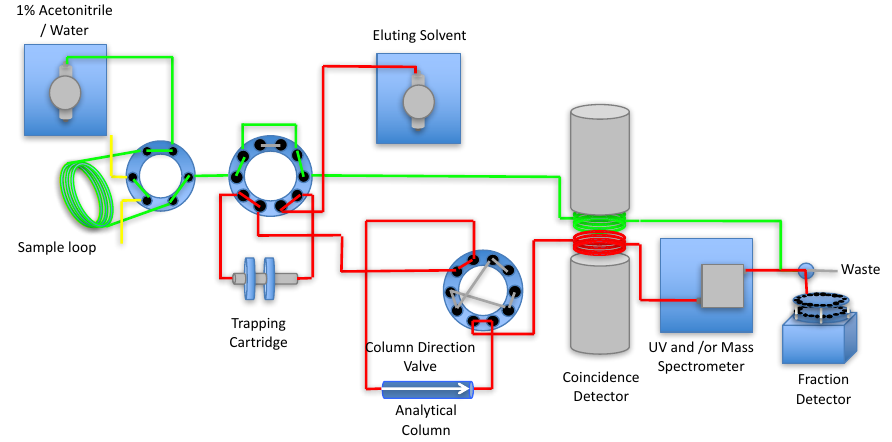
Figure 5. The elution of the plasma sample from the trapping cartridge to the analytical column which is analyzed by the coincidence detector, UV detector and/or mass